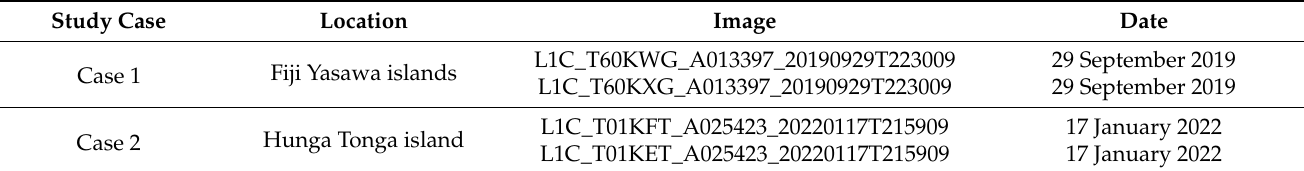
Table 1. MSI images used in this